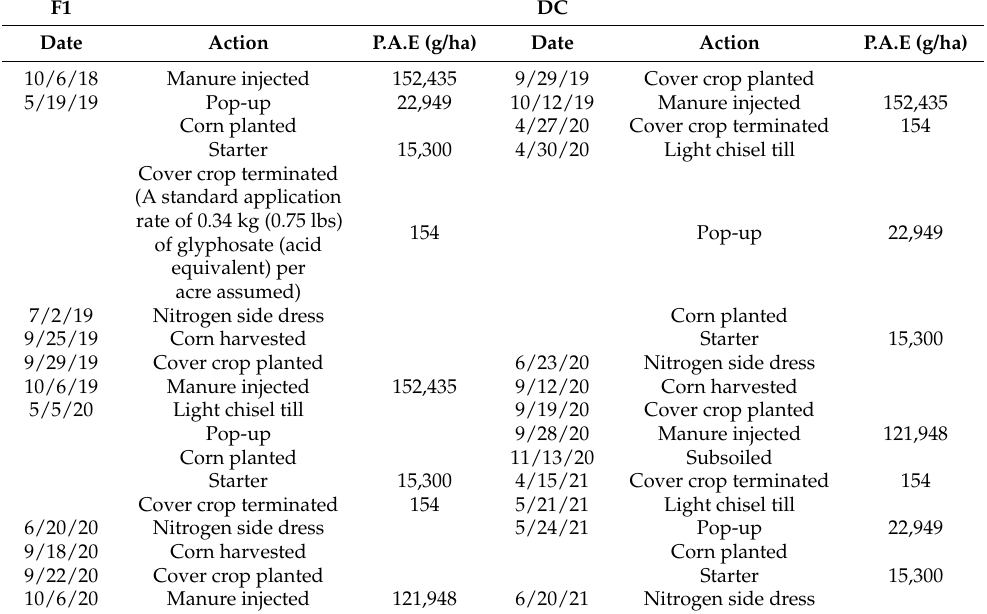
Table 1. Site management practices and timing. P.A.E. is P application equivalent. Nitrogen side dress was entirely urea ammonium nitrate (UAN), and the cover crop was Winter Rye ( Secale cereale